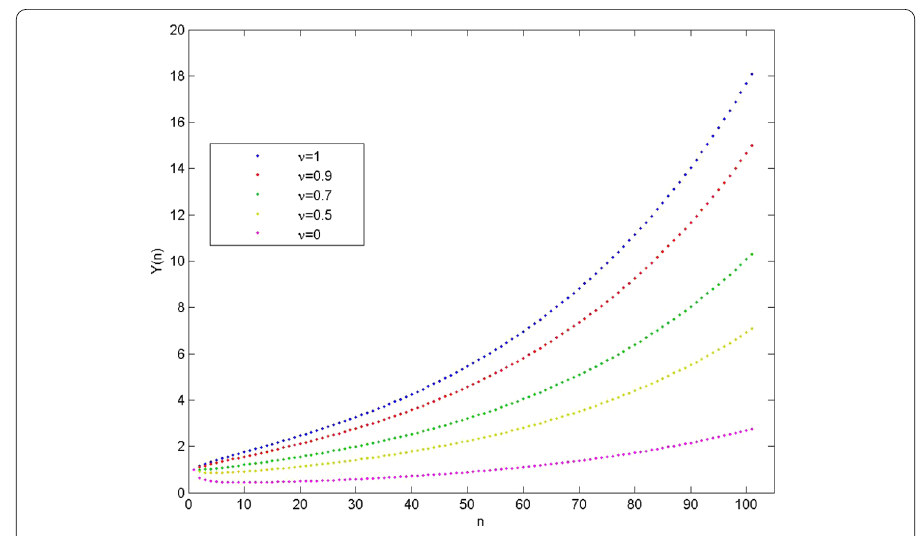
Figure 2 Solutions for λ = 0.1, μ = 0.5 and different values of ν